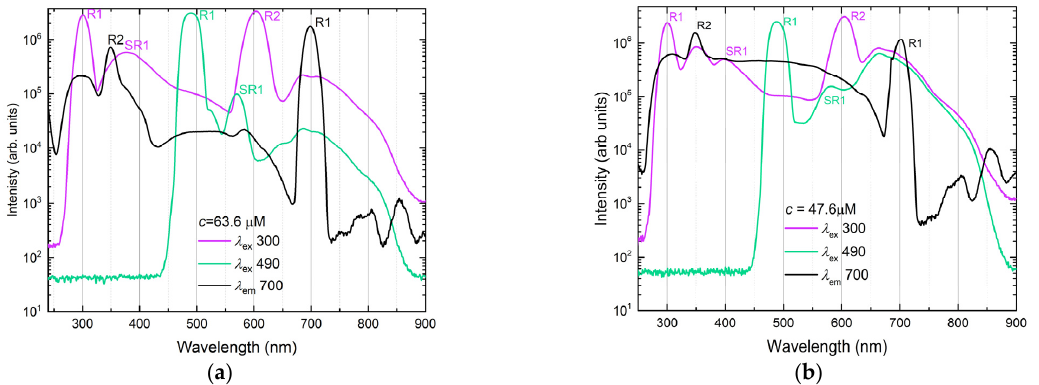
Figure 7. Log-scale fluorescence emission (excitation wavelengths, 310 nm, magenta line and symbols and 490 nm, green line and symbols) and fluorescence excitation spectra (emission wavelength, 700 nm, black line and symbols): ( a ) C 60 in n -hexane, 63.6 µM; ( b ) C 70 in benzene, 47.6 µM. Bands marked R1 and R2 are 1st and 2nd-order Rayleigh sca tt ering; bands marked SR1 are 1st-order Stokes Raman sca tt ering. Excitation/emission slits, 14/14 nm; detector voltage, 950 V; accumulation time 0.5 s per point.